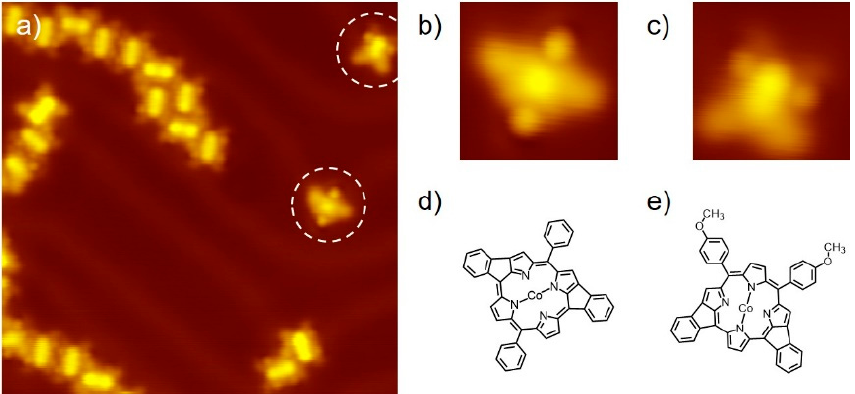
Figure 3. STM image of ( a ) annealed Co(TAP) self-assembly on surface at 523 K; ( b , c ) two types of intermediates as the dehydrocyclization products where only two of the four meso -methyl groups are coupled with the pyrrole groups; ( d , e ) proposed chemical structures for the products shown in ( b , c ), respectively. Imaging conditions: − 0.3 V, 20 pA. Image size: (a) 20 × 20 nm 2 ; ( b , c ) 4 × 4 nm 2 .